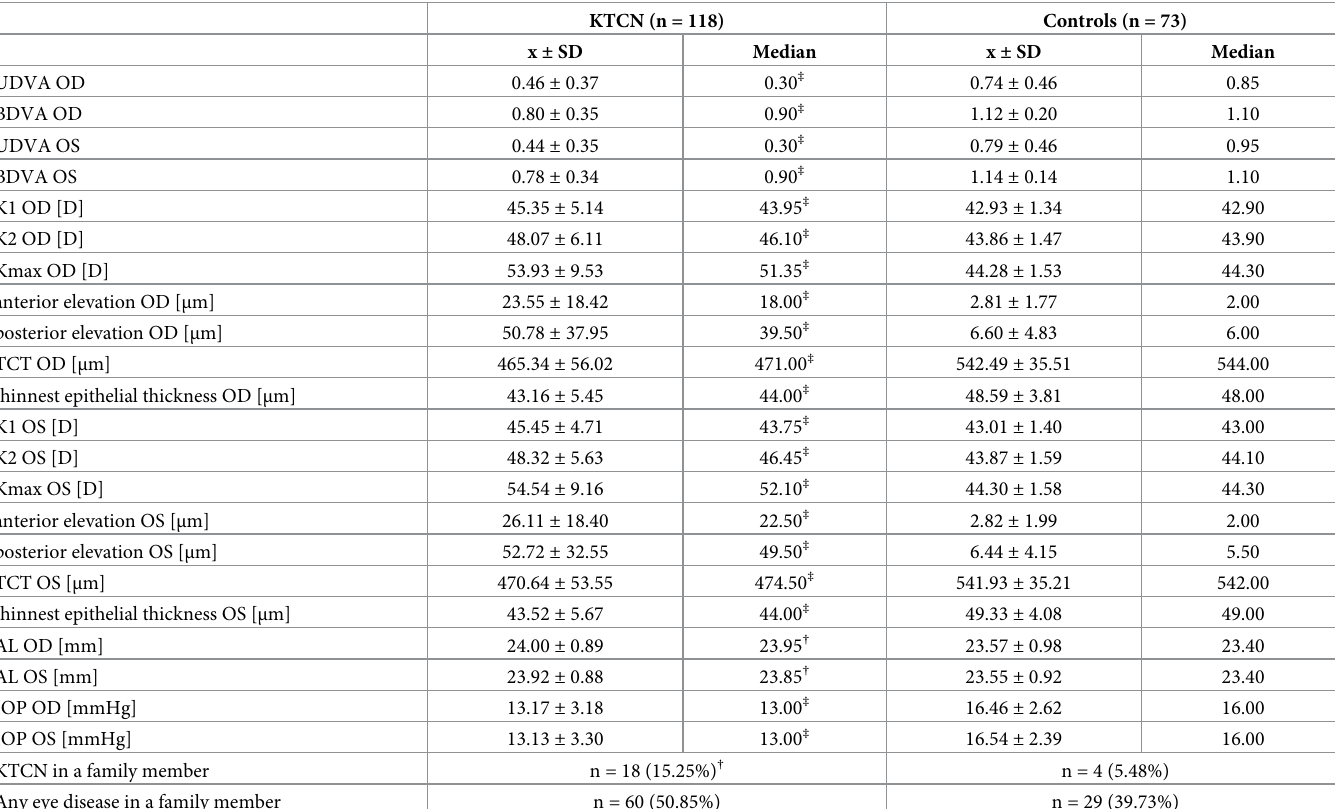
Table 1. Clinical characteristics of the examined patients with KTCN and control individuals. The statistically significant differences, p � 0.05 or p < 0.001, are indicated.